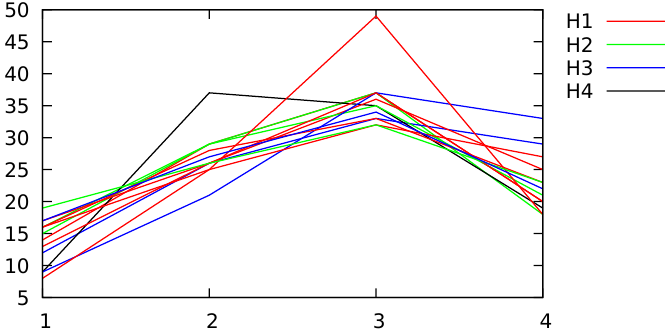
Figure 9. Contribution of magnitudes belonging to different distances to SSAMD for targets lo- cated at a specific height interval: X -axis—height interval of contributing magnitudes, Y -axis—the contribution in percent, colored lines—targets located at a specific height